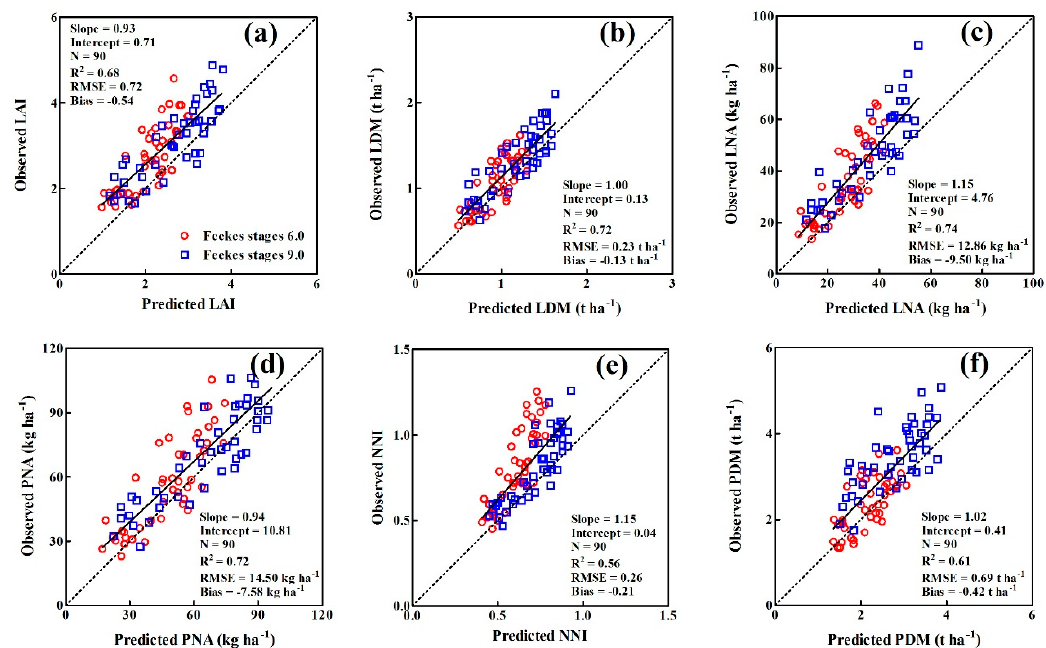
Figure 4. Validation results obtained using the model based on the difference vegetation index (DVI) to predict ( a ) leaf area index (LAI), ( b ) leaf dry matter (LDM), ( c ) leaf nitrogen accumulation (LNA), ( d ) plant nitrogen accumulation (PNA), and ( e ) nitrogen nutrition index (NNI) and the model based on the red edge ratio vegetation index (RERVI) to predict ( f ) the plant dry matter (PDM) at Feekes stages 6.0–10.0. Solid black lines indicate regression lines and dotted black lines indicate 1:1 lines.